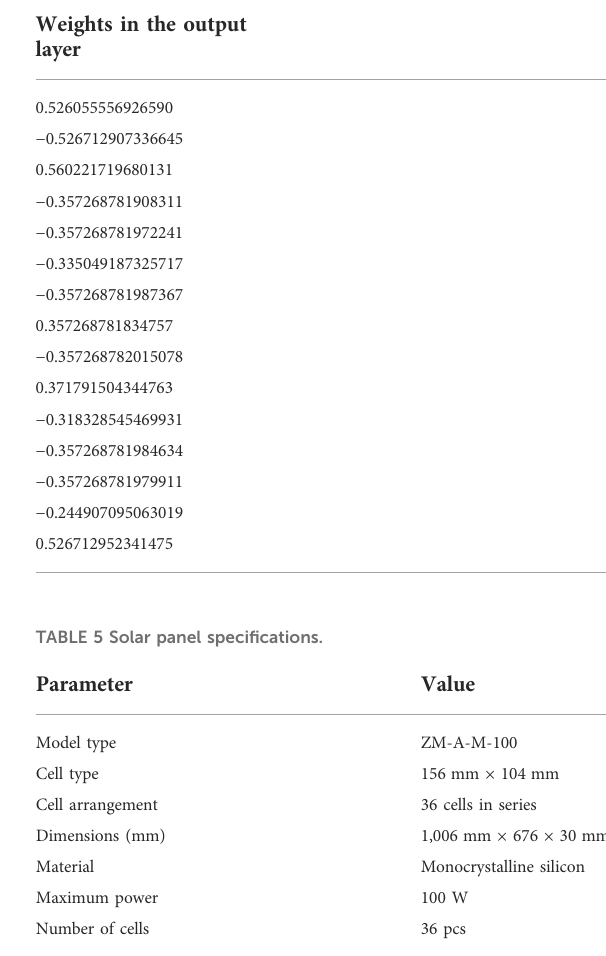
TABLE 4 Weights in the output layer.